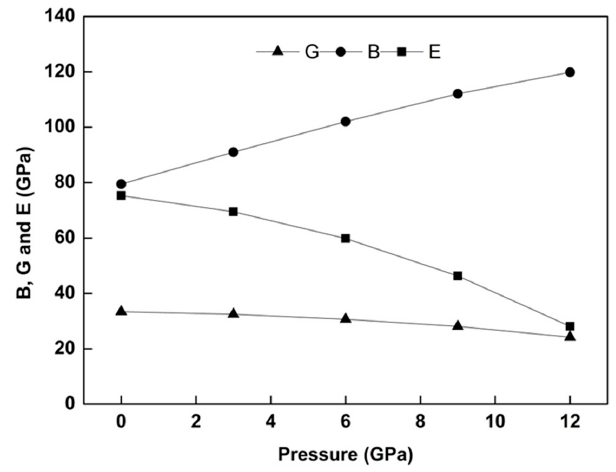
Figure 3. Elastic moduli (B, G, and E) behavior of WZ ZnS versus pressure.